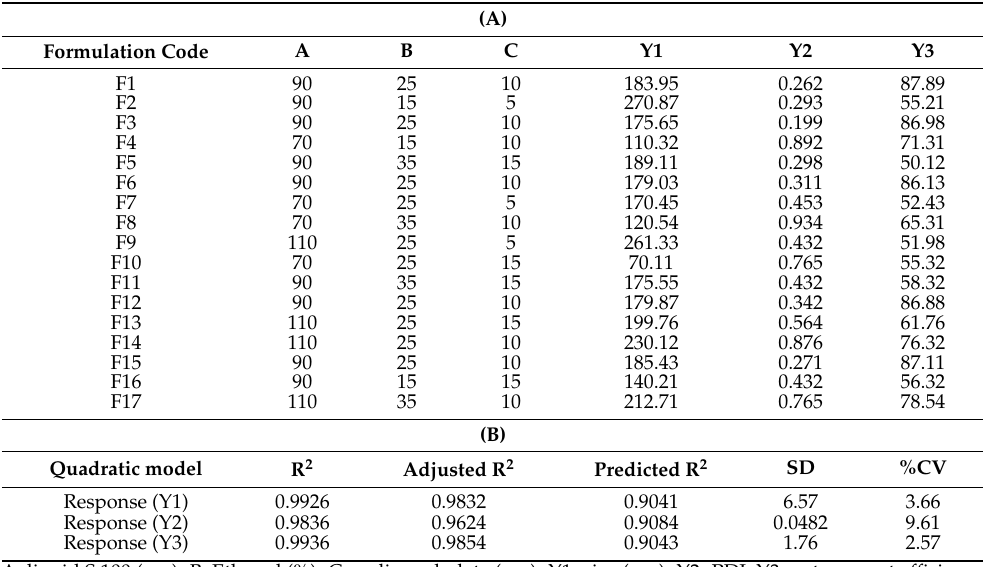
Table 1. ( A ) Observed responses for the HTC-loaded TES formulations during development and optimization. ( B ) Projected values produced by Design Expert software. (A) Formulation